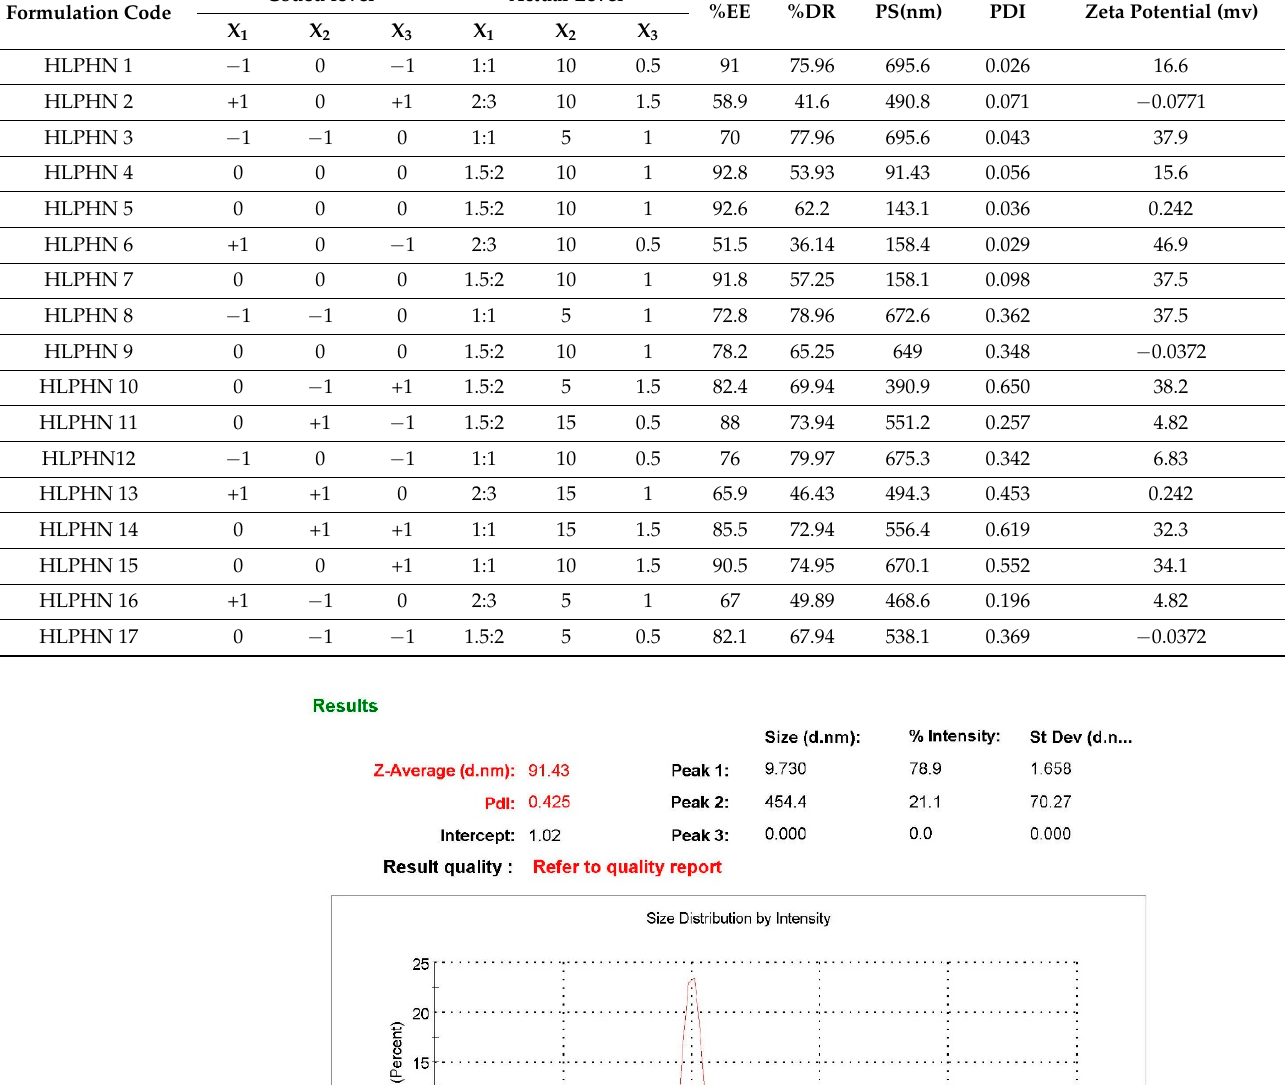
Table 3. Data of EE, DR, PS, PDI and Zeta Potential of various batches of HLPHNs.